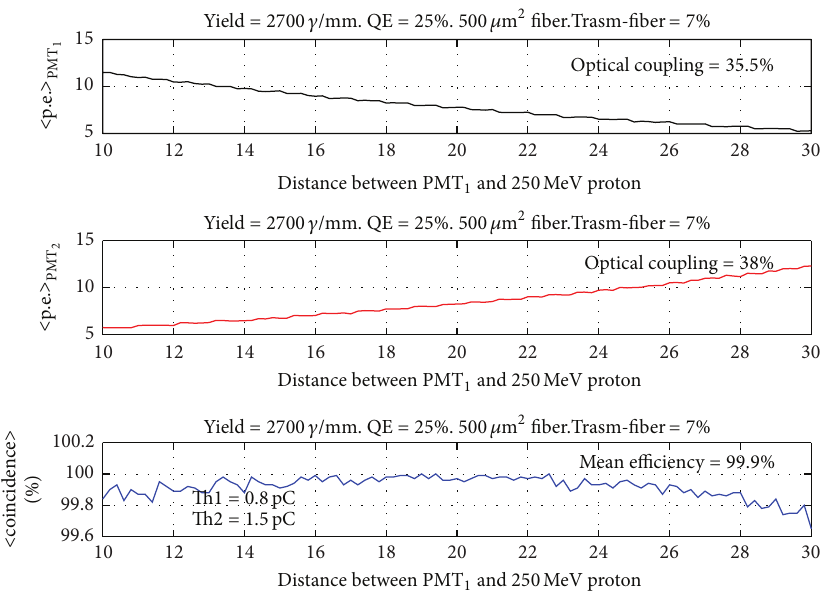
Figure 14: Photoelectrons produced as a function of the impact position for the two PMTs and detection efficiency.